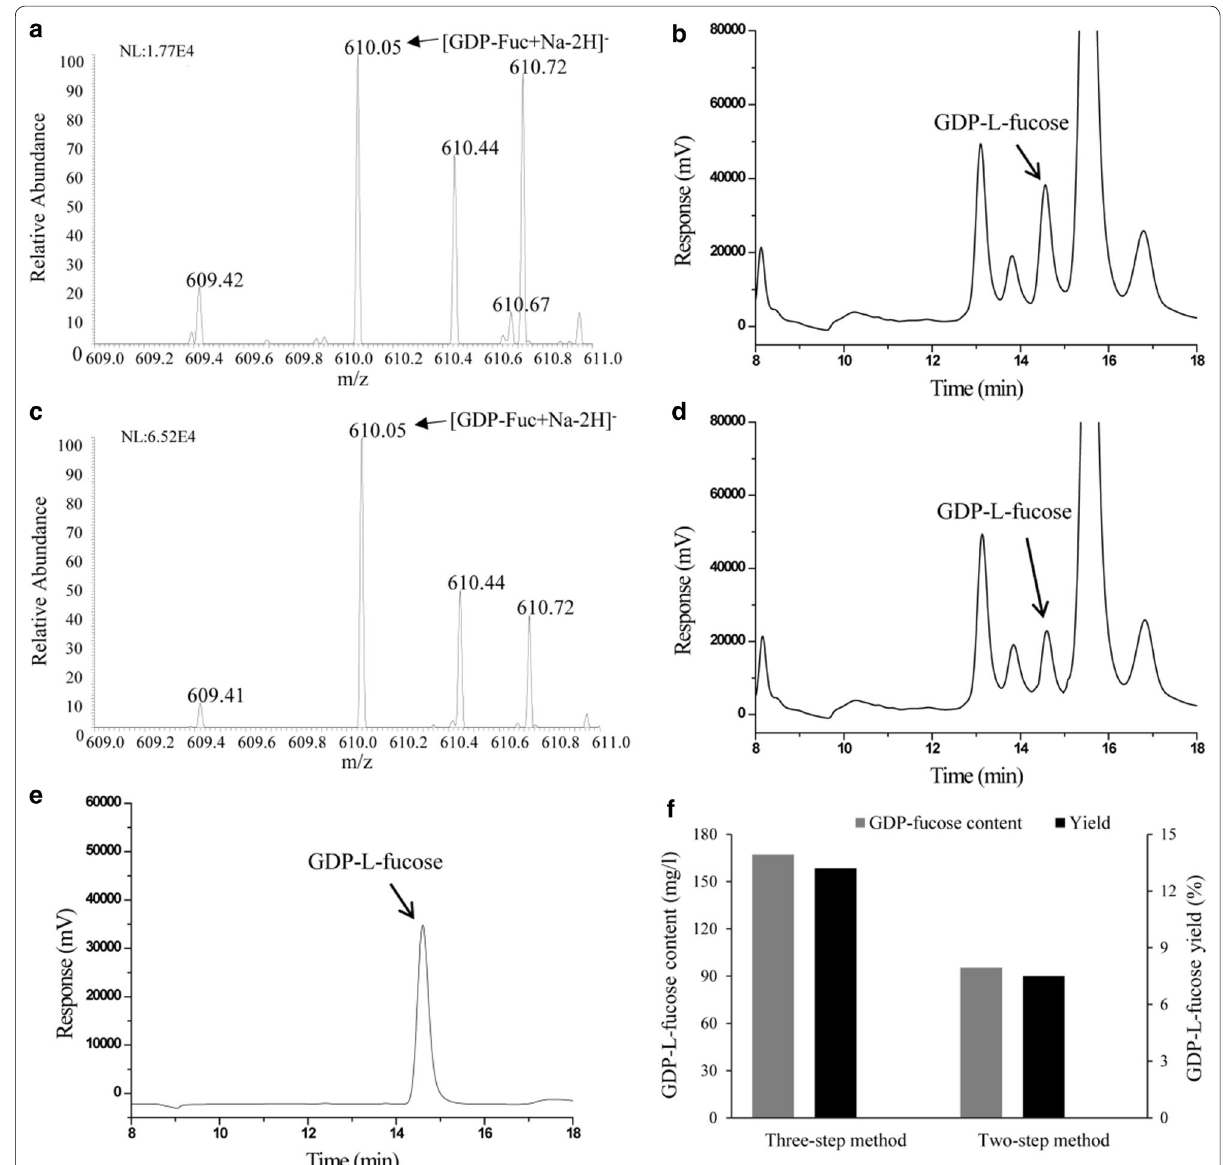
Fig. 5 Conversion of mannose to GDP- l -fucose using three-step method and two-step method. MS [three-step method ( a ), two-step method ( c )] and HPLC [three-step method ( b ), two-step method ( d ), standard sample ( e )] analysis of GDP- l -fucose. The final content and yield of GDP- l